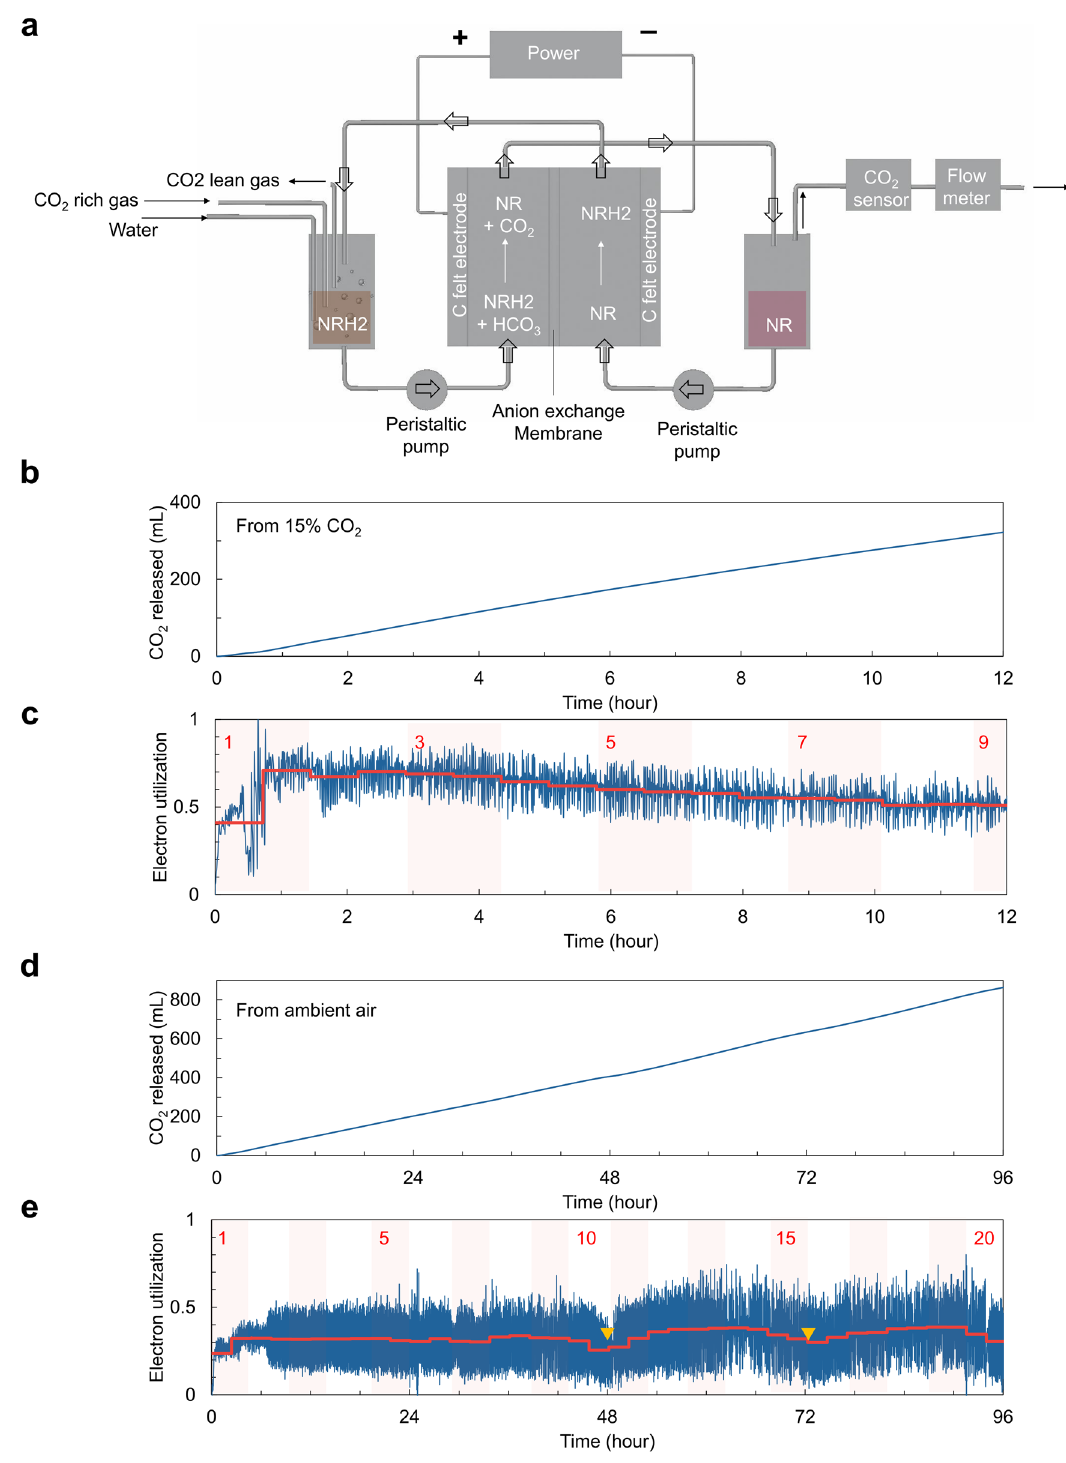
Fig. 6 | Continuous fl ow operation of the NR/NRH2 redox system. a Scheme of continuous fl ow electrochemical cell using the NR/NRH2 redox cycle for CO 2 captureandreleaseexperiments. b ReleasedCO 2 amountovertimewithafeedgas composition of 15% CO 2 . c Electron utilization over time with a feed gas con- centration of 15%CO 2 .Electrolytes comprised15mLof 50mM NRH2in1M NAand 1M KCl and 15mL of 50mM NRH in 1M NA and 1M KCl in water. The red curve indicates the average value of electron utilization for each one-way travel